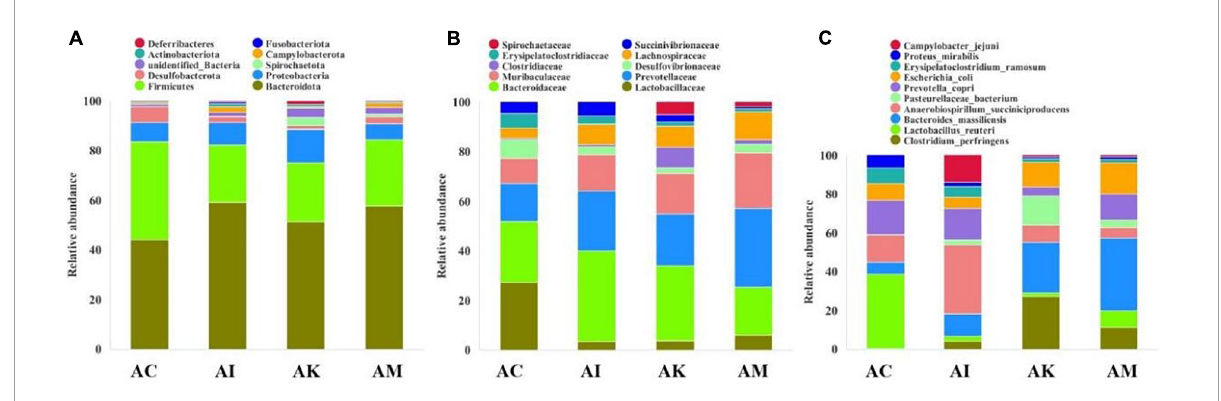
FIGURE4 The intestinal microbiota composition changes of mice with acute T. gondii infection at 6 dpi. AC: no T. gondii + PBS; AI: 50 T. gondii cysts + PBS; AK: 50 T. gondii cysts + koumiss; AM: 50 T. gondii cysts + mare’s milk; (A–C) indicate phylum, family and species levels, respectively. All data are expressed as mean ±